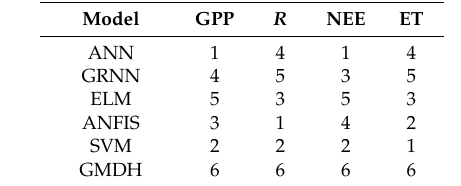
Table 3. Model performance rankings of the data-driven models for carbon and water fluxes for the testing